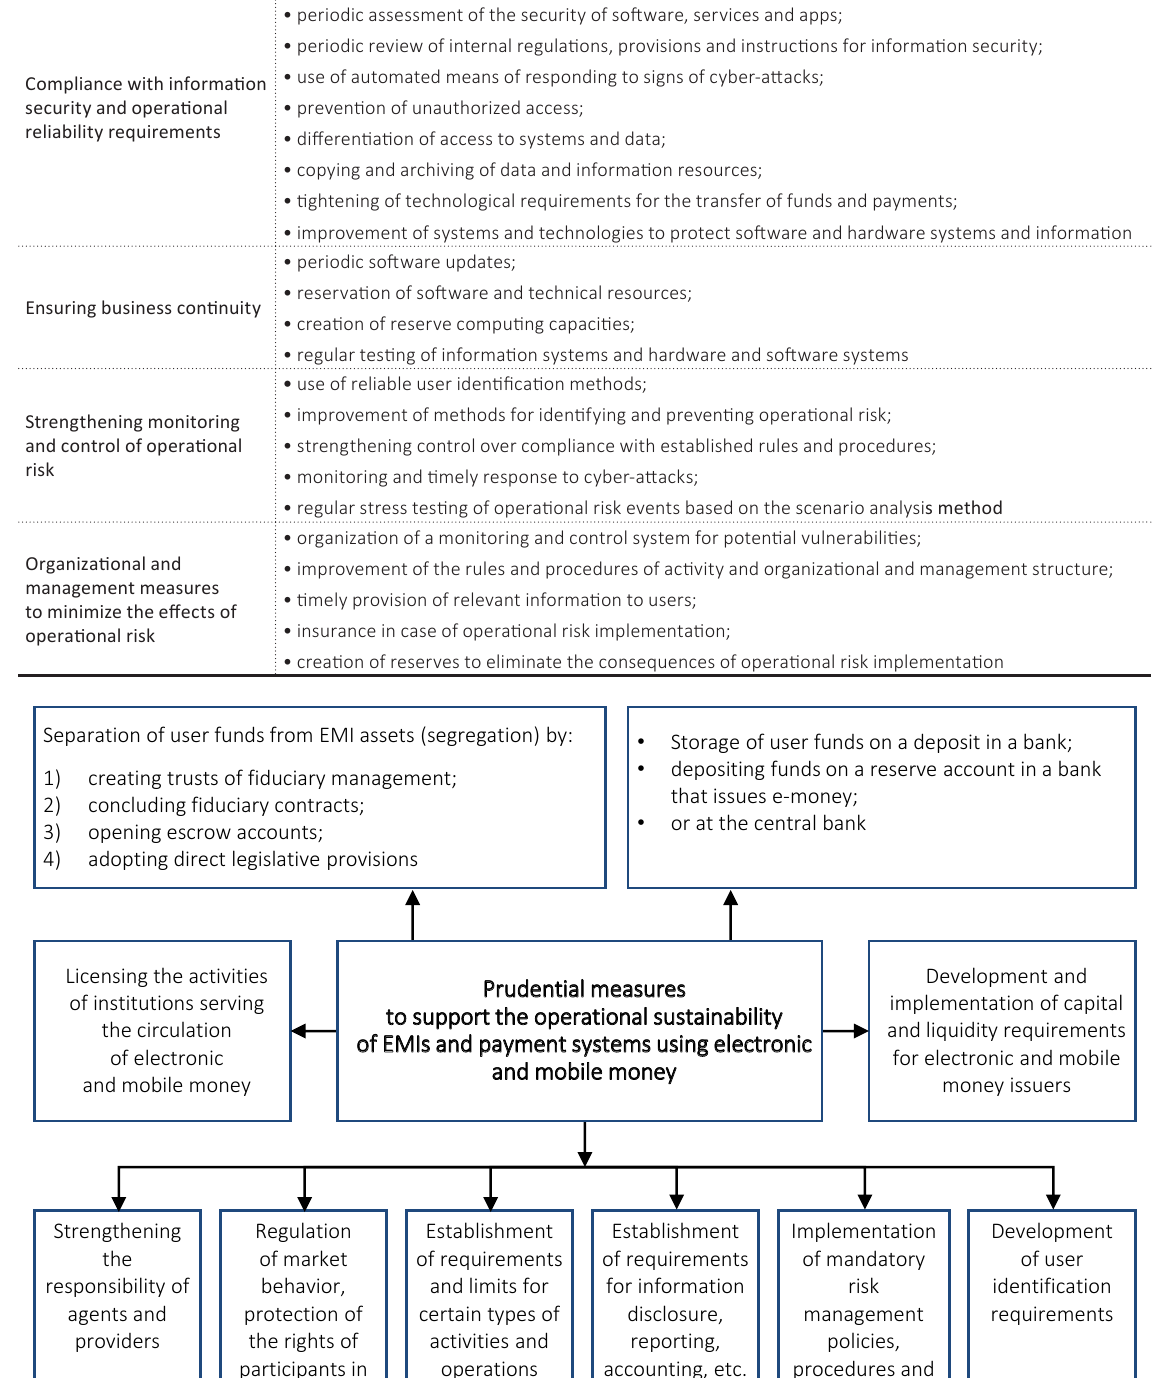
Table 7. Measures to prevent and limit the impact of operational risk factors to maintain proper operational sustainability of EMIs Areas Characteristics of measures